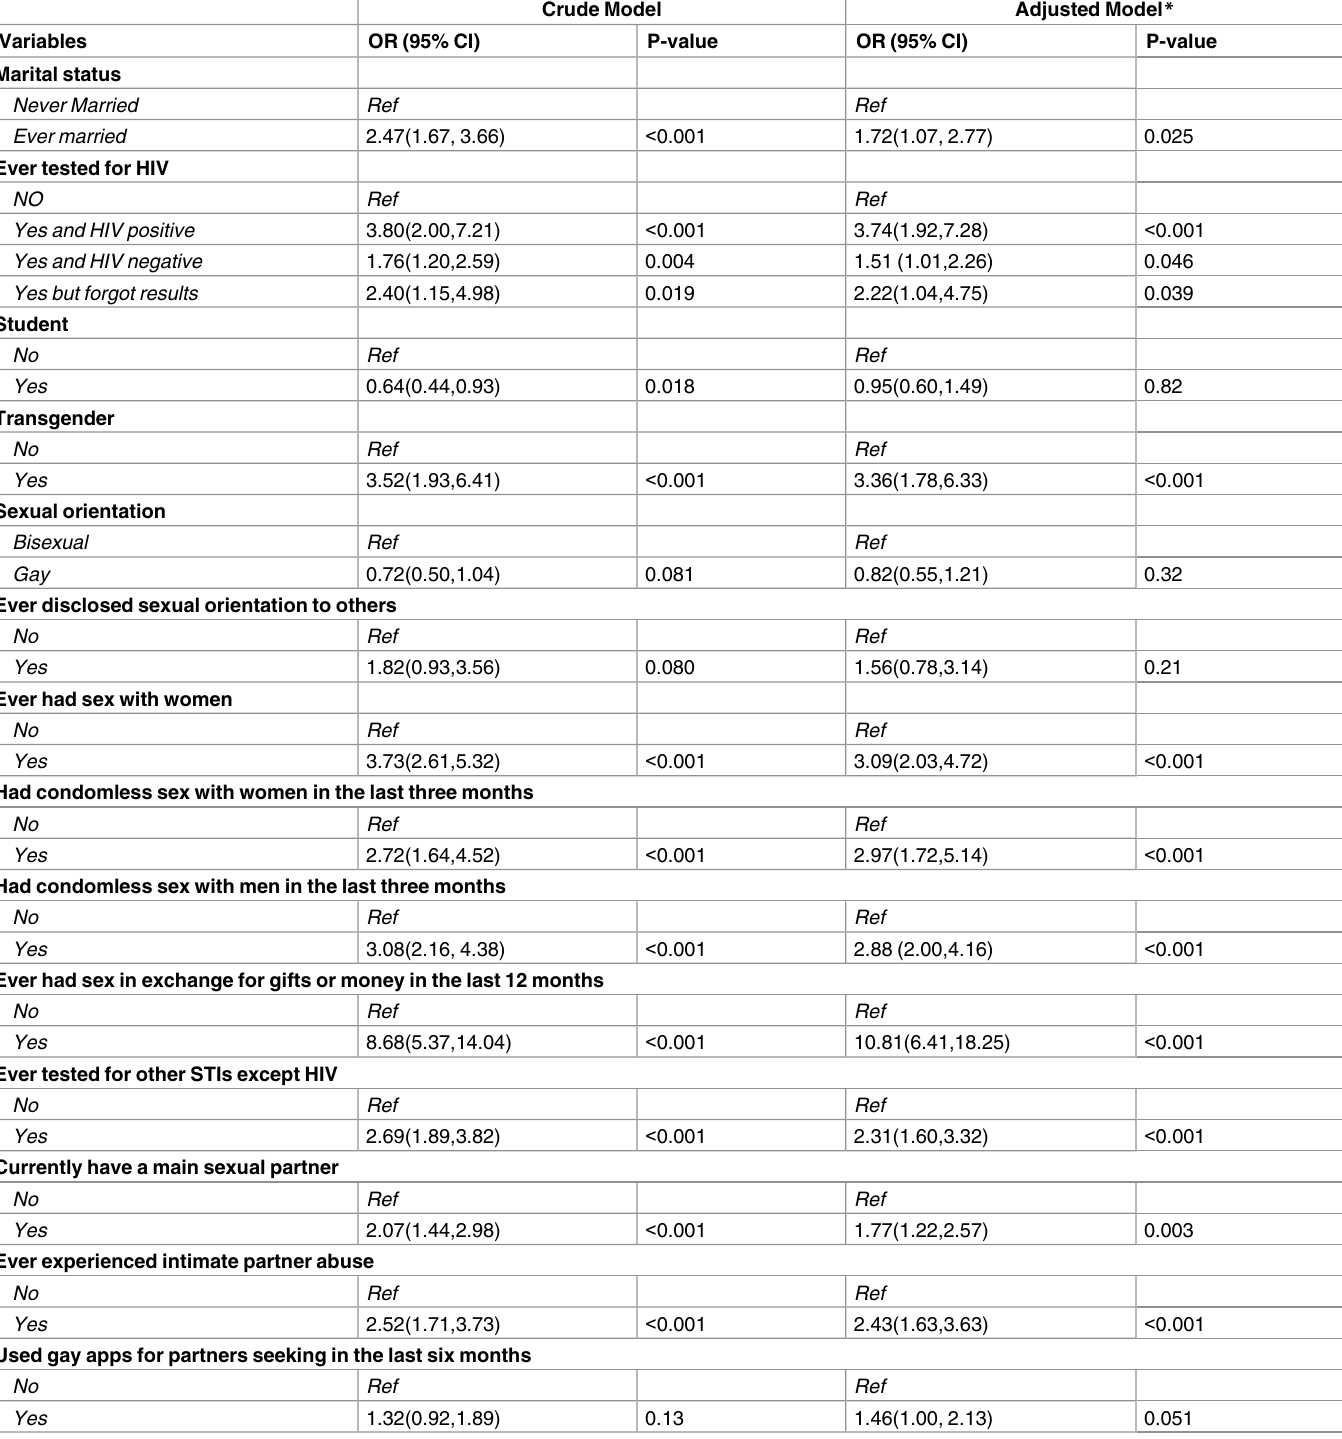
Table 2. Factors associate to group sex among Chinese MSM from an online survey, 2014 (N =